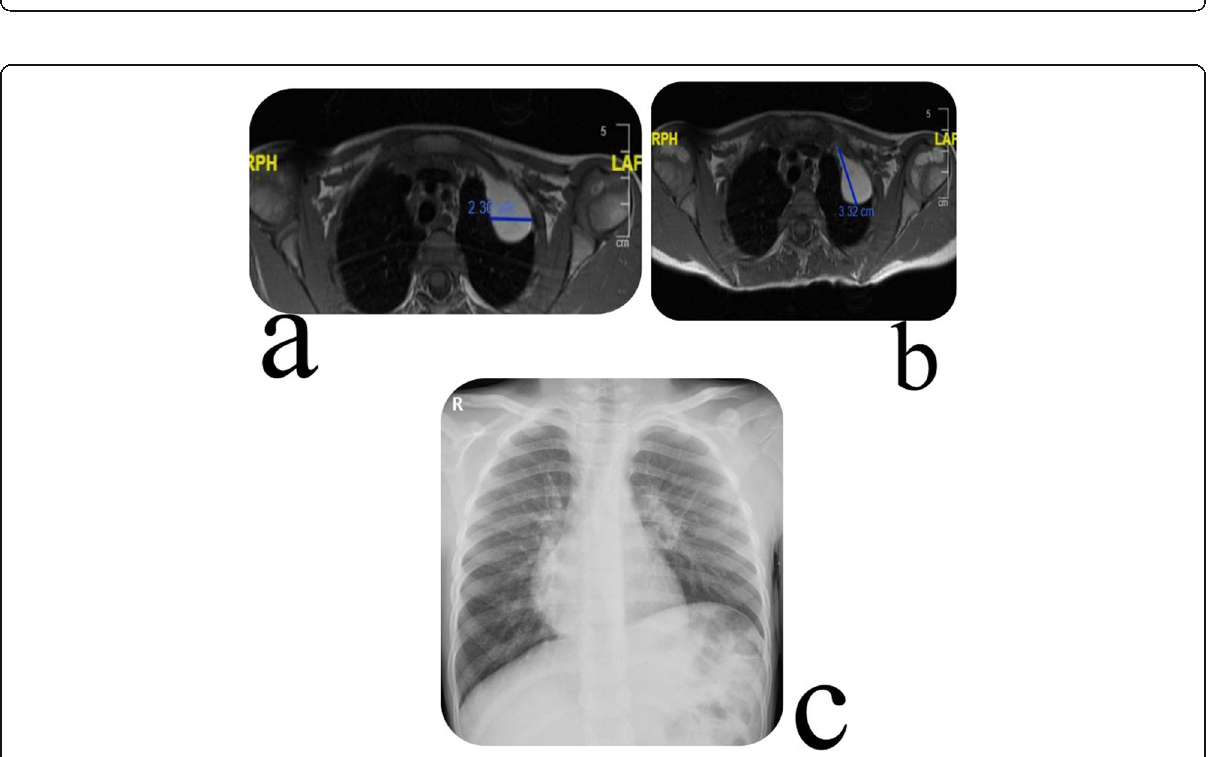
Fig. 3 a , b Intrathoracic lipoblastoma remnant. c Follow-up